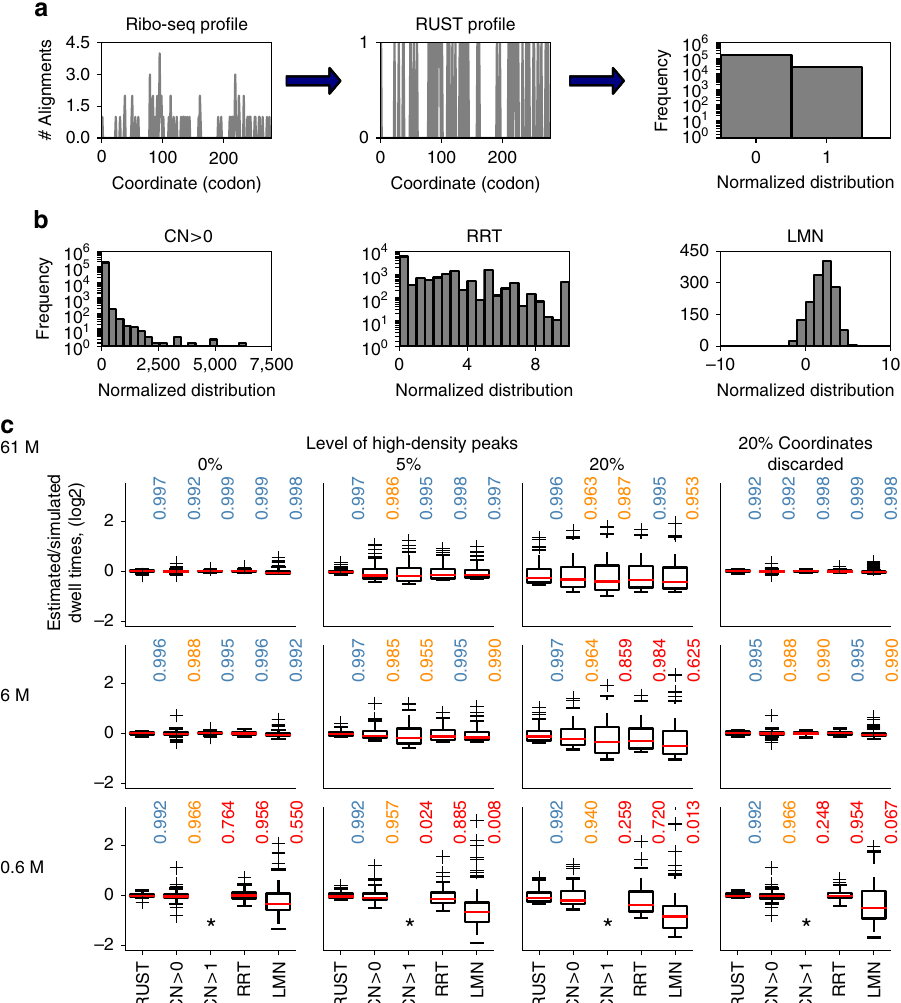
Figure 1 | Comparison of ribosome profiling normalization approaches. ( a ) A stylized footprint density profile for MTIF3 gene transcript from ‘Andreev’ data set (left) is transformed into a binary function with RUST (centre). Each sequence feature, such as AAA codon in the case shown, could be characterized by its frequency as 1 or 0 (right). ( b ) The distributions of normalized codon densities for all AAA codons in ‘Andreev’ data set using different approaches, conventional normalization CN (left), ribosome residence time, RRT (top right) and logarithmic mean normalization, LMN (right). Note that due to intrinsic differences the scale of possible normalized densities (axis x ) varies among the methods and that due to the selection criteria of each approach the number of datapoints used (axis y ) is also variable. ( c ) Performance of five normalization approaches (RUST, CN of transcripts with average gene density 4 1/nucleotide (CN 4 1) and CN of all expressed transcripts (CN 4 0), LMN and RRT) at estimating codon dwell times The box plots show the distribution of log values of the estimated/simulated dwell times for all 61 codons. The deviations of these values from 0 occur due to under or overestimation of simulated dwell times. The better methods are those that have distributions with a smaller variance. Each subpanel represents a specific scenario. The simulation scenarios differ by coverage that reduces from top to the bottom and the level of noise modelled as high peaks of density that increases from left to right, except for the right-most column where noise is modelled as missing data at 20% of the coordinates. Asterisks used to indicate insufficient data for CN 4